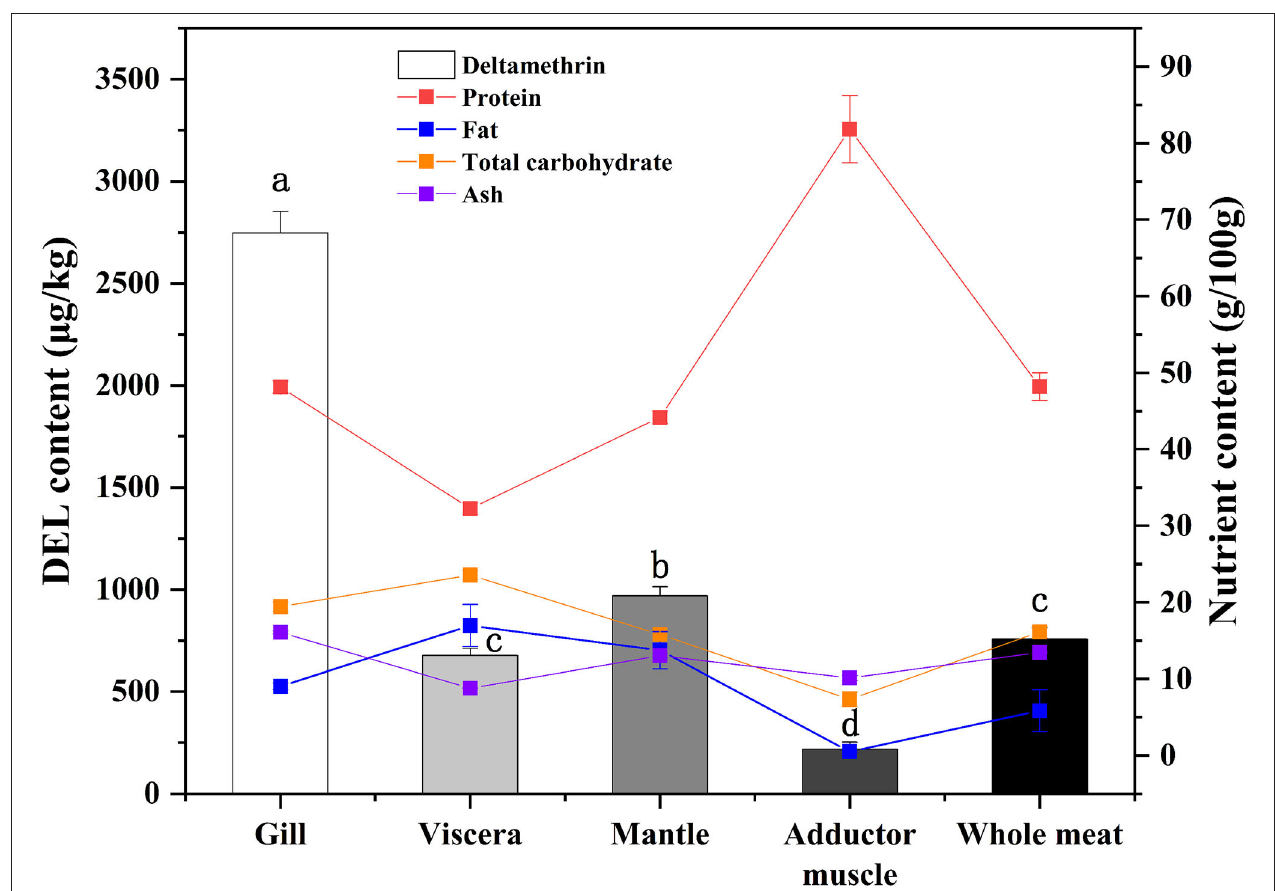
FIGURE 2 | Concentrations of DEL and proximate composition in different tissues of oyster. Lowercase letters represent differences in DEL concentration between tissues (gill, viscera, mantle, muscle, and whole meat) of oyster (ANOVA, p <